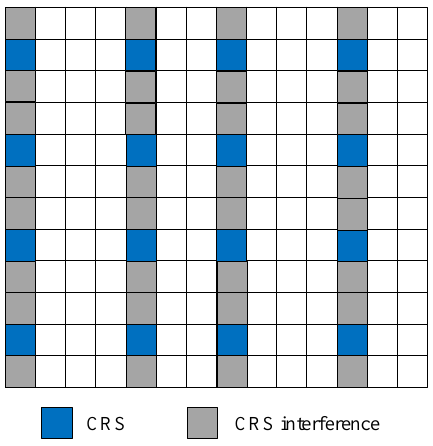
Figure 6. Schematic diagram of DSS